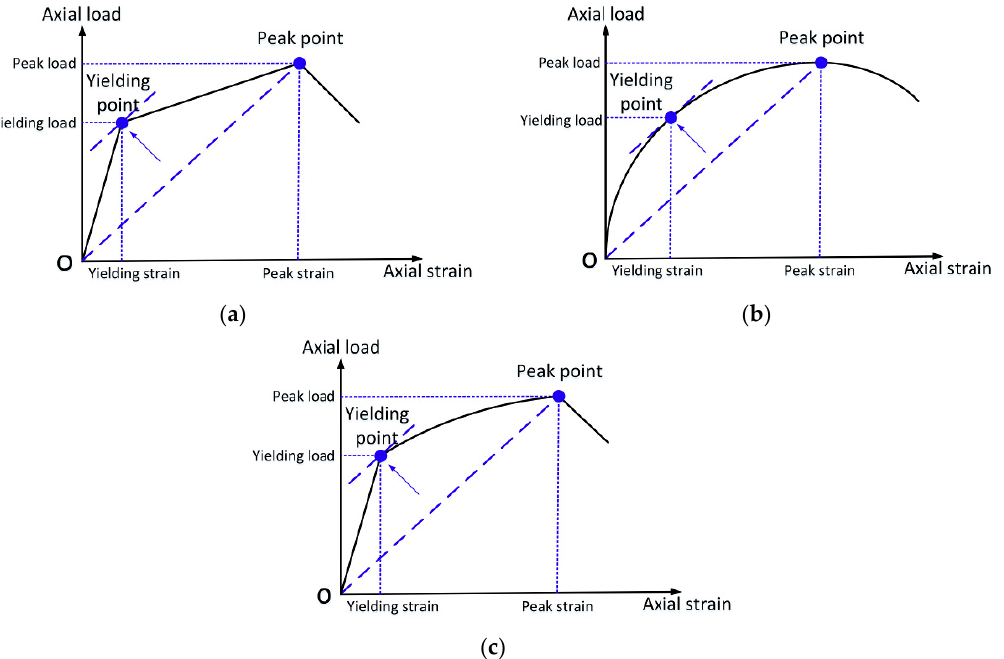
Figure 9. Method to determine the yielding point proposed by Feng [24]: ( a ) tri-linear curve; ( b ) curve without an obvious inflection point and ( c ) a traditional elastic–plastic curve.